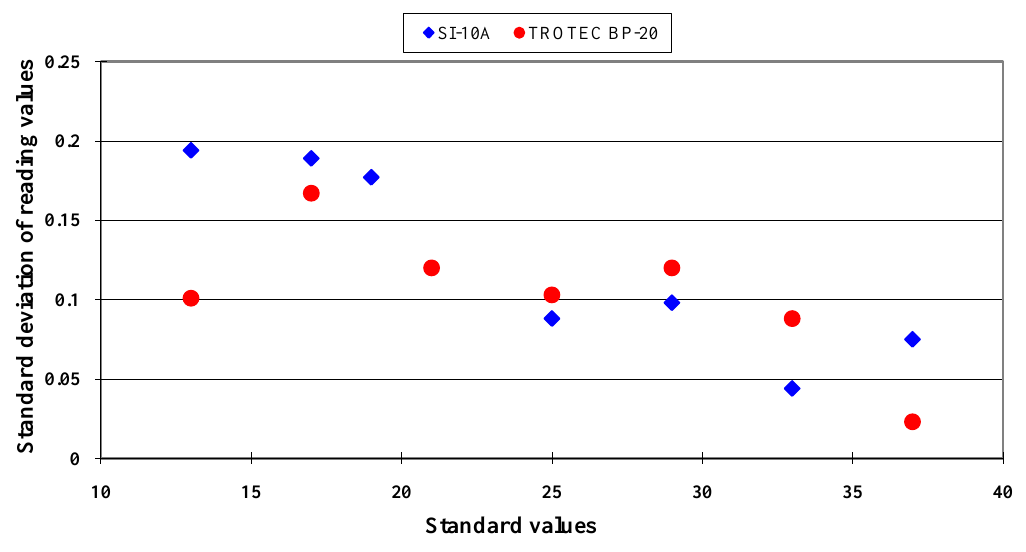
Table 2. The calibration equations and statistics of the SENTRON SI-10A infrared thermocouple, measurement ranged from 13  C to 37  C.